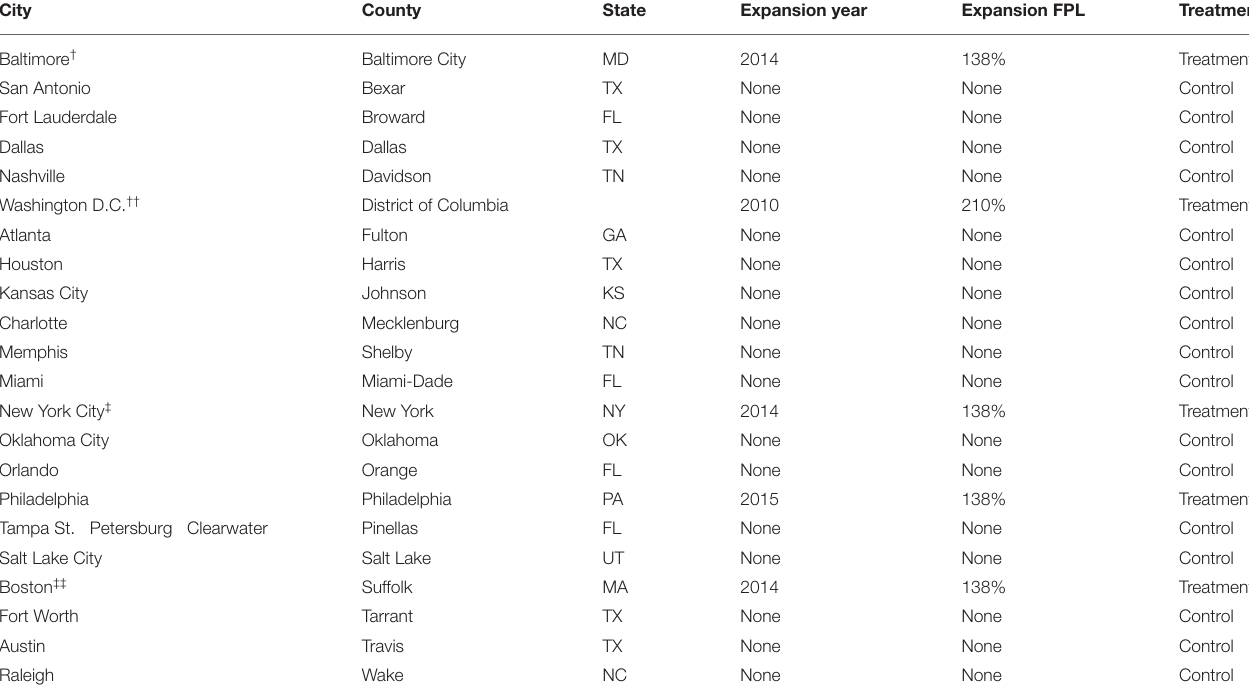
TABLE 1 | Treatment conditions of included